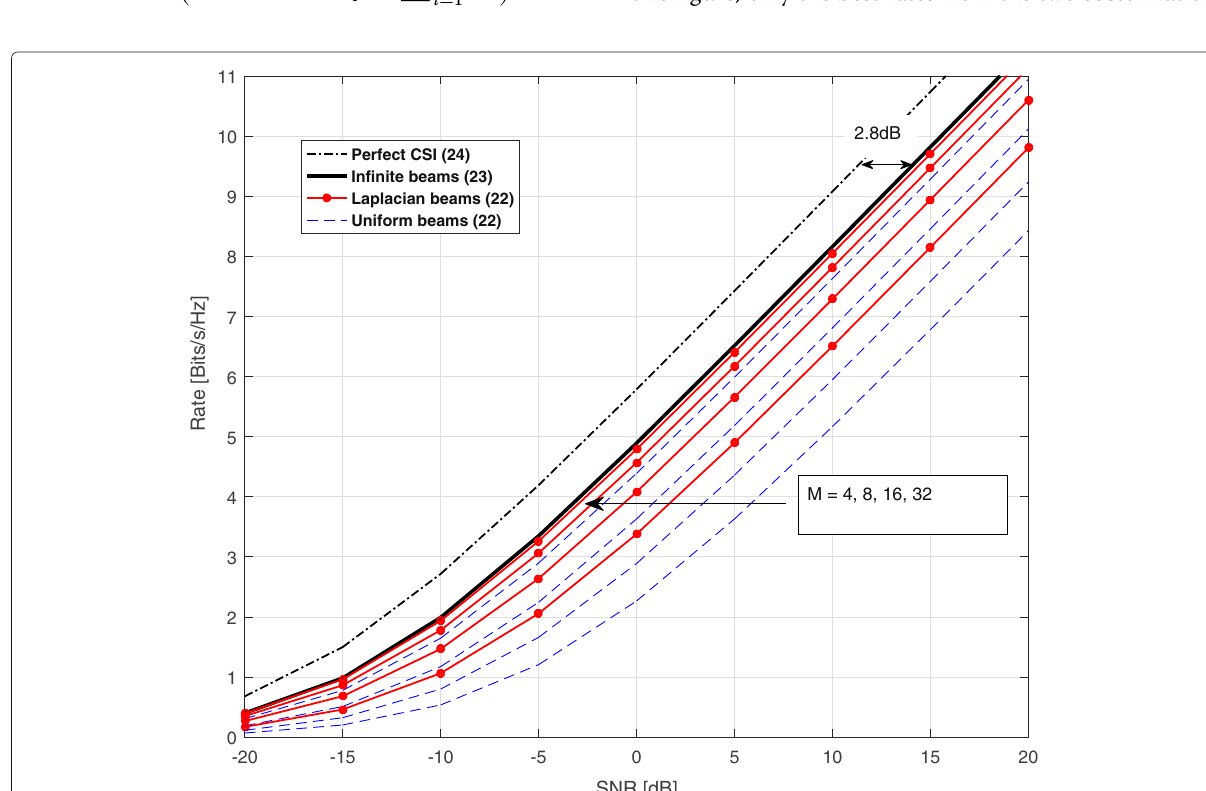
Fig. 2 Spectral efficiency achieved by Laplacian beam codebooks compared to uniform beam codebooks for various numbers of codebook sizes M = { 4,8,16,32 } and N p =